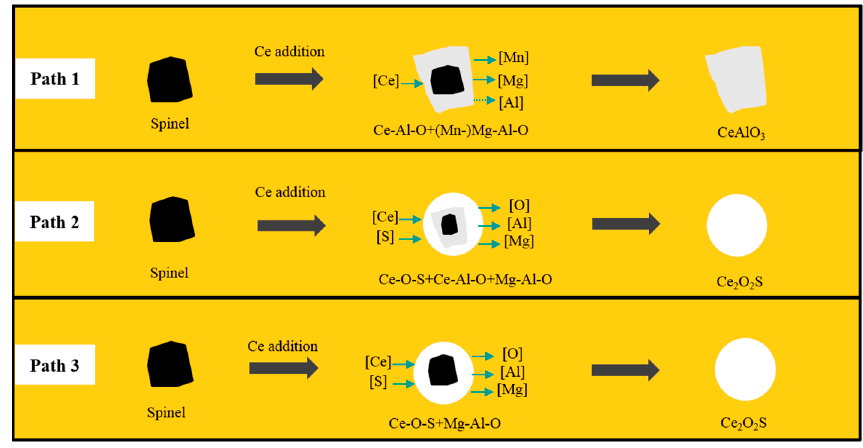
Figure 6. Modification mechanism of spinel inclusions.